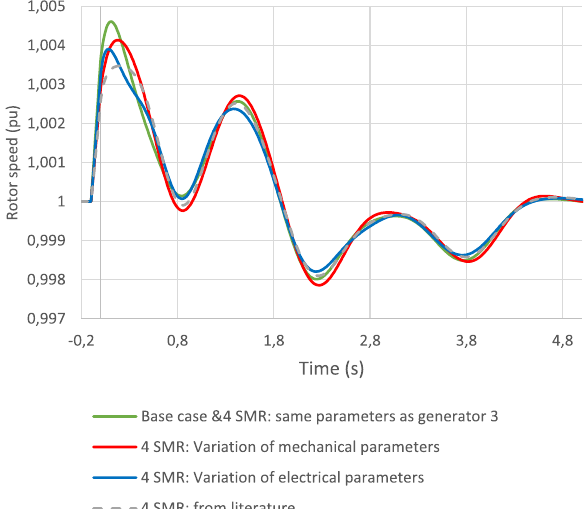
Fig. 12. Evolution of rotor speed with different machine set of